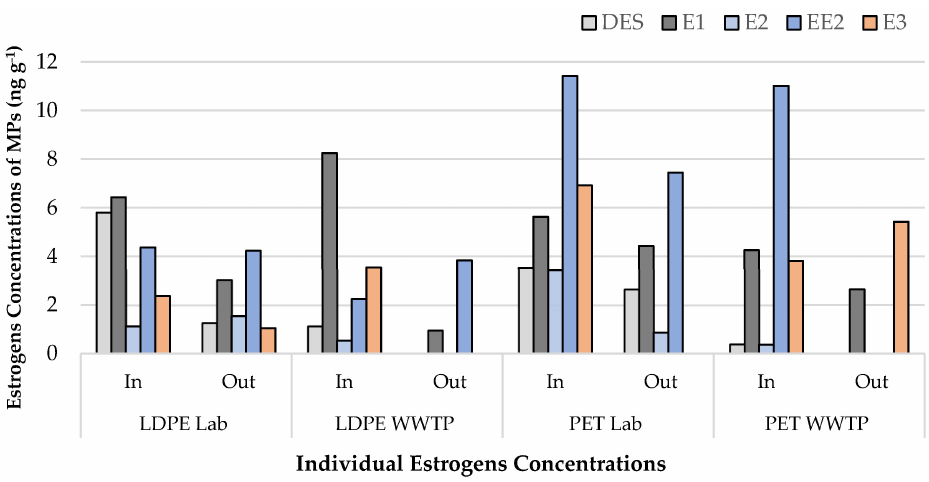
Figure 2. Individual estrogen concentrations in ng g − 1 in WWTP and laboratory conditions. Lab: laboratory exposed; WWTP: wastewater treatment plant; In: influent; Out: effluent; DES: diethyl- stilbestrol; E1: estrone; E2: 17 β -estradiol; E3: estriol; EE2: 17 α -ethinyl